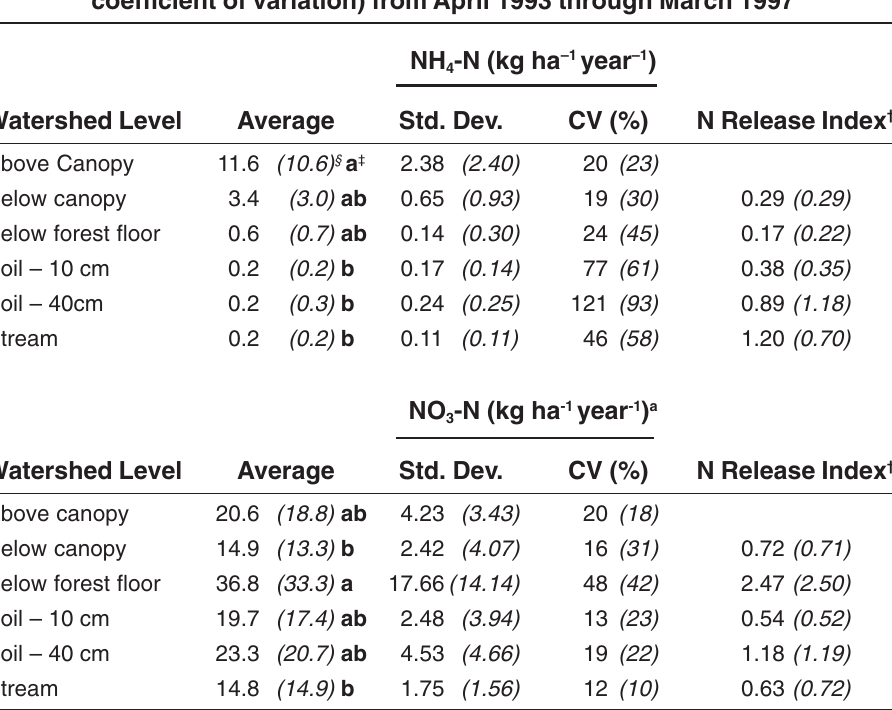
Average Annual Inorganic N Fluxes at Different Levels in the NDW (average, standard deviation and coefficient of variation) from April 1993 through March